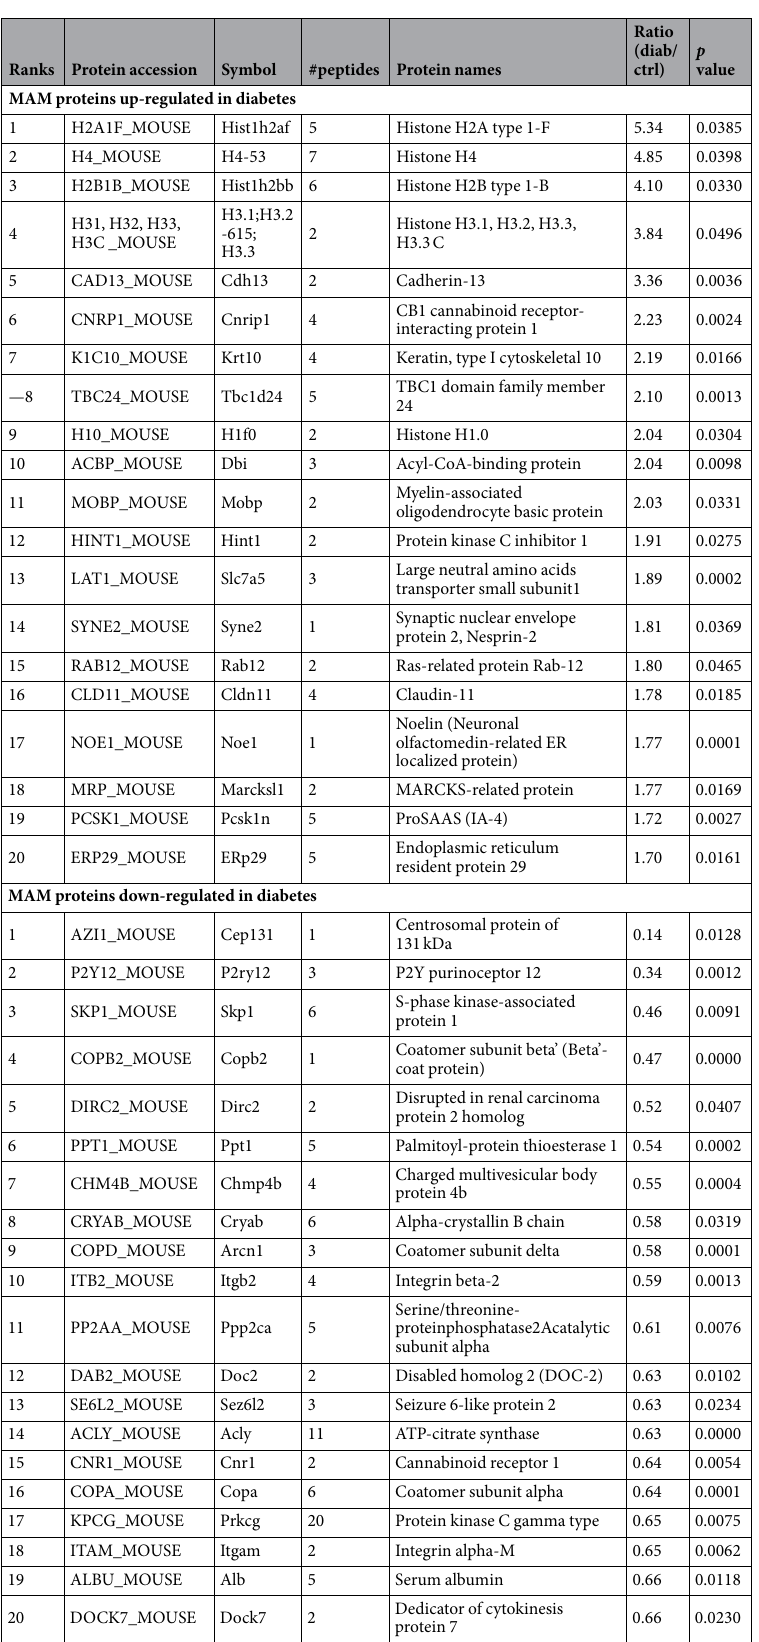
Table 1. Top 20 significantly up- or down-regulated MAM proteins in